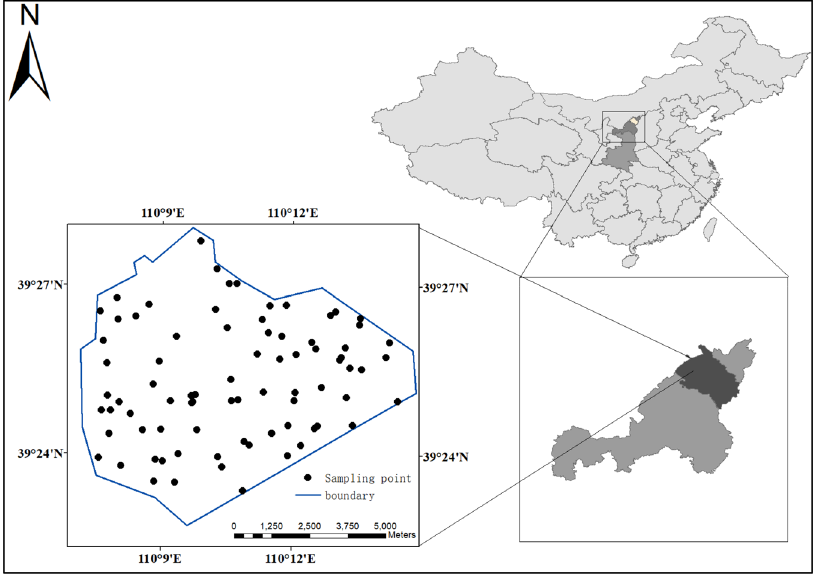
Figure 1. Location of the research area and the distribution of sampling points (created by Arcgis 10.8, http:// deskt op. arcgis. com/ cn/).